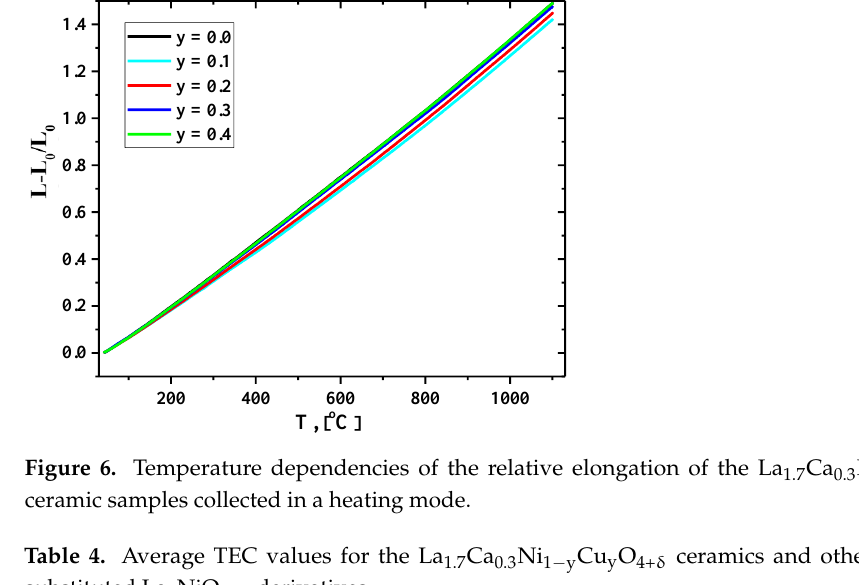
substituted La 2 NiO 4+ δ